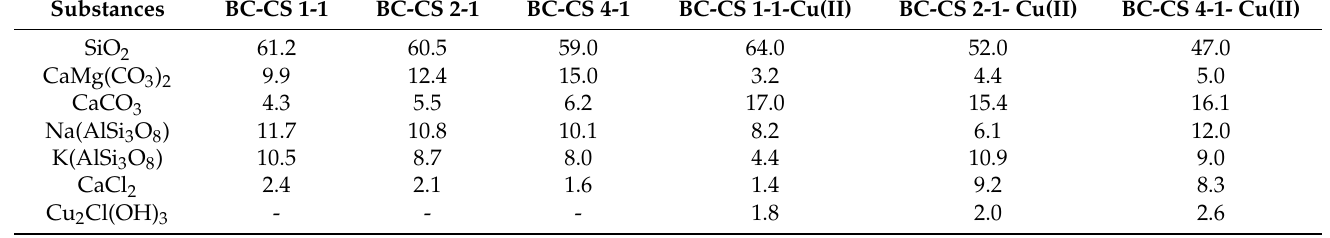
Table 2. Semi-quantitative analysis of BC-CS 1-1, BC-CS 2-1 and BC-CS 4-1 based on the XRD meth- ods before and after the Cu(II) ion sorption.